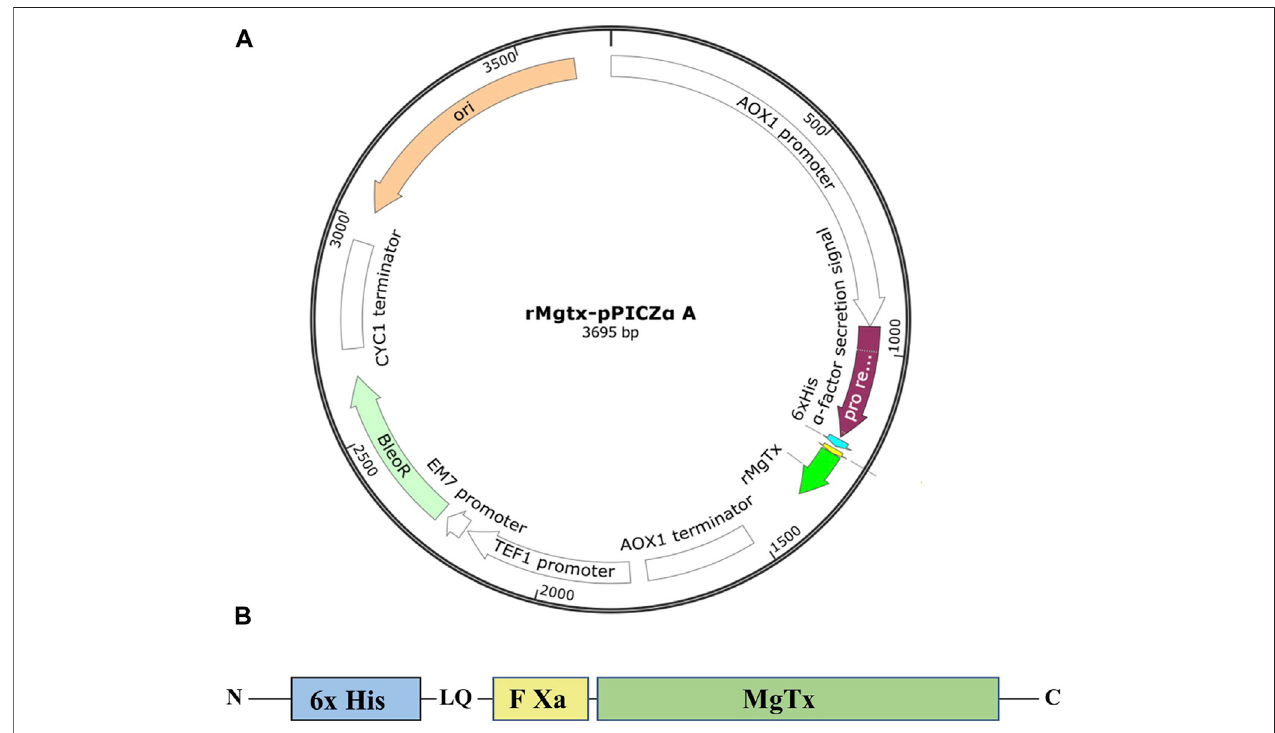
FIGURE 1 | (A) Graphical representation of recombinant plasmid TrMgTx – pPICZ α A designed using the SnapGene ® tool. (B) Schematic demonstration of the TrMgTx cassette.